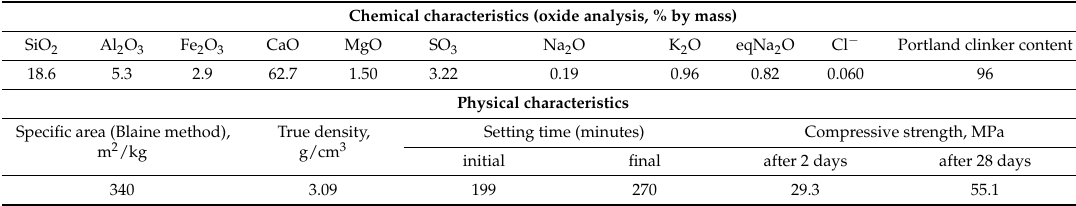
Table 1. Chemical and physical characteristics of cement CEM I 42.5